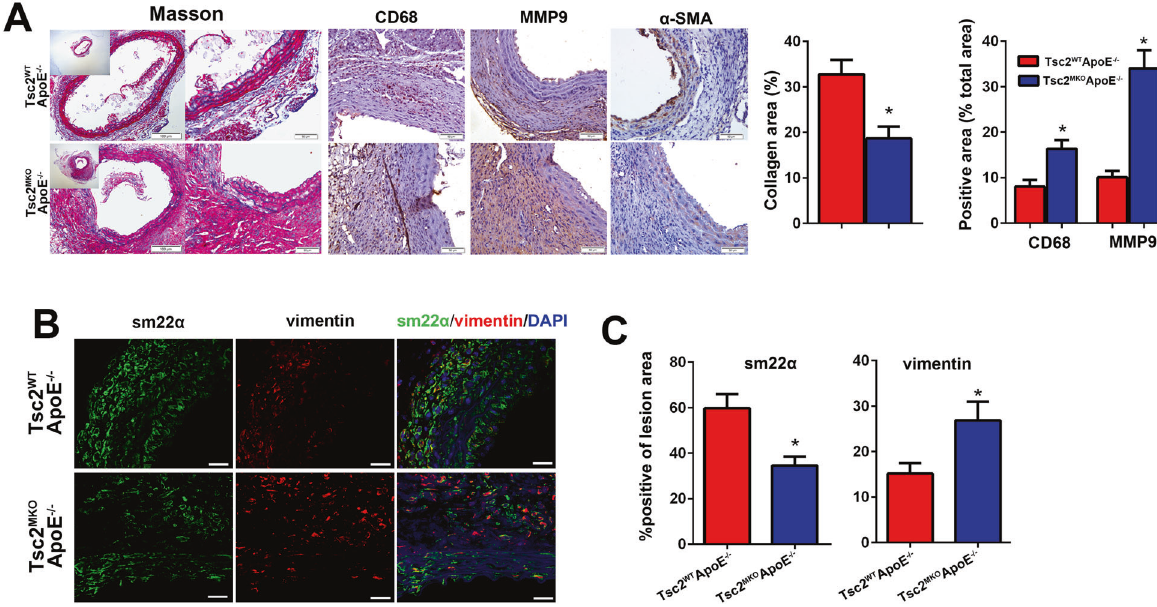
Fig. 3 Myeloid-speci fi c deletion of Tsc2 promotes AngII infusion – induced aortic structural and composition changes. A Masson and immunohistochemical staining of the abdominal aortic sections for CD68, α -SMA, and Mmp9 in Tsc2 WT ApoE – / – and Tsc2 MKO ApoE – / – mice receiving AngII infusion for 28 d ( n = 5). B Immuno fl uorescence staining of sm22 α (green) and vimentin (red) in abdominal aortic sections ( n = 5). C Quanti fi cation of sm22 α and vimentin coverage ( n = 5). Scale bar = 50 µm. * P < 0.05, vs. Tsc2 WT ApoE – / – mice infused with